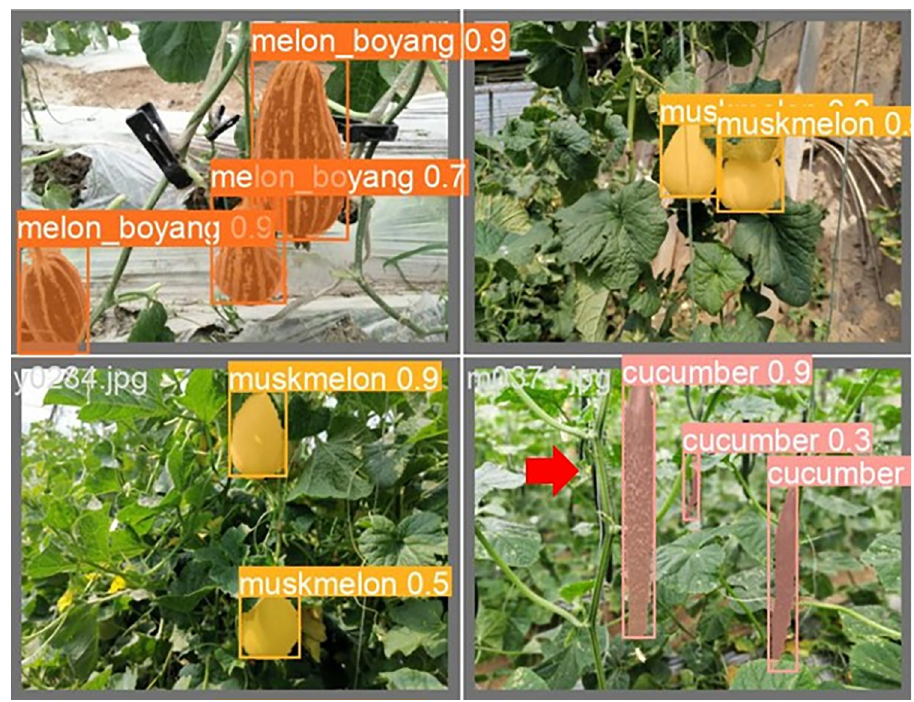
Fig 12. Image results of YOLOv5-GhostNet.